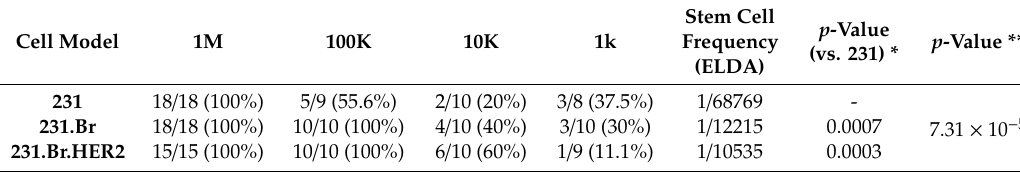
Figure 2. Brain ‐ tropic metastatic breast cancer cells display an increased tumorigenic ability in the choriallantoic membrane of the chick embryo (CAM). ( A ) Representative pictures of tumors formed in the CAM, taken under a stereomicroscope (4× magnification). ( B ) Hematoxilin ‐ eosin (HE) staining of the CAM tumors. Scale bar = 20 μ m. ( C ) Illustrative representation of the immunohistochemical evaluation of the breast cancer stem cell markers CD44 and CD49f in CAM tumors. Scale = 20 μ m. ( D ) Tumor size evaluation in a limiting dilution assay performed in the CAM, by inoculation of 1M, 100K, 10K, and 1K cell number per egg. Each dotted point corresponds to an independent biological replicate (1M: 18, 18, 15 eggs; 100K: 9, 10, 10 eggs; 10K: 10, 10, 10 eggs; and 1K: 8, 10, 9 eggs for 231, 231.Br, and 231.Br.HER2 respectively). Statistical analysis * p < 0.05, *** p < 0.001, **** p < 0.001). Table 1. Number of tumors formed in the di ff erent cell lines using serial dilutions of inoculated cells (limiting dilution assays). 8–18 independent biological replicates have been performed in the di ff erent conditions (1M: 18, 18, 15 eggs; 100K: 9, 10, 10 eggs; 10K: 10, 10, 10 eggs and 1K: 8, 10, 9 eggs for 231, 231.Br and 231.Br.HER2 respectively). Using the ELDA software (http: // bioinf.wehi.edu.au / software / elda / ), a stem cell frequency was determined. A significant di ff erence was obtained between the parental 231 and the brain-tropic variants (231.Br and 231.Br.HER2), however no significant enrichment is observed for 231.Br vs.